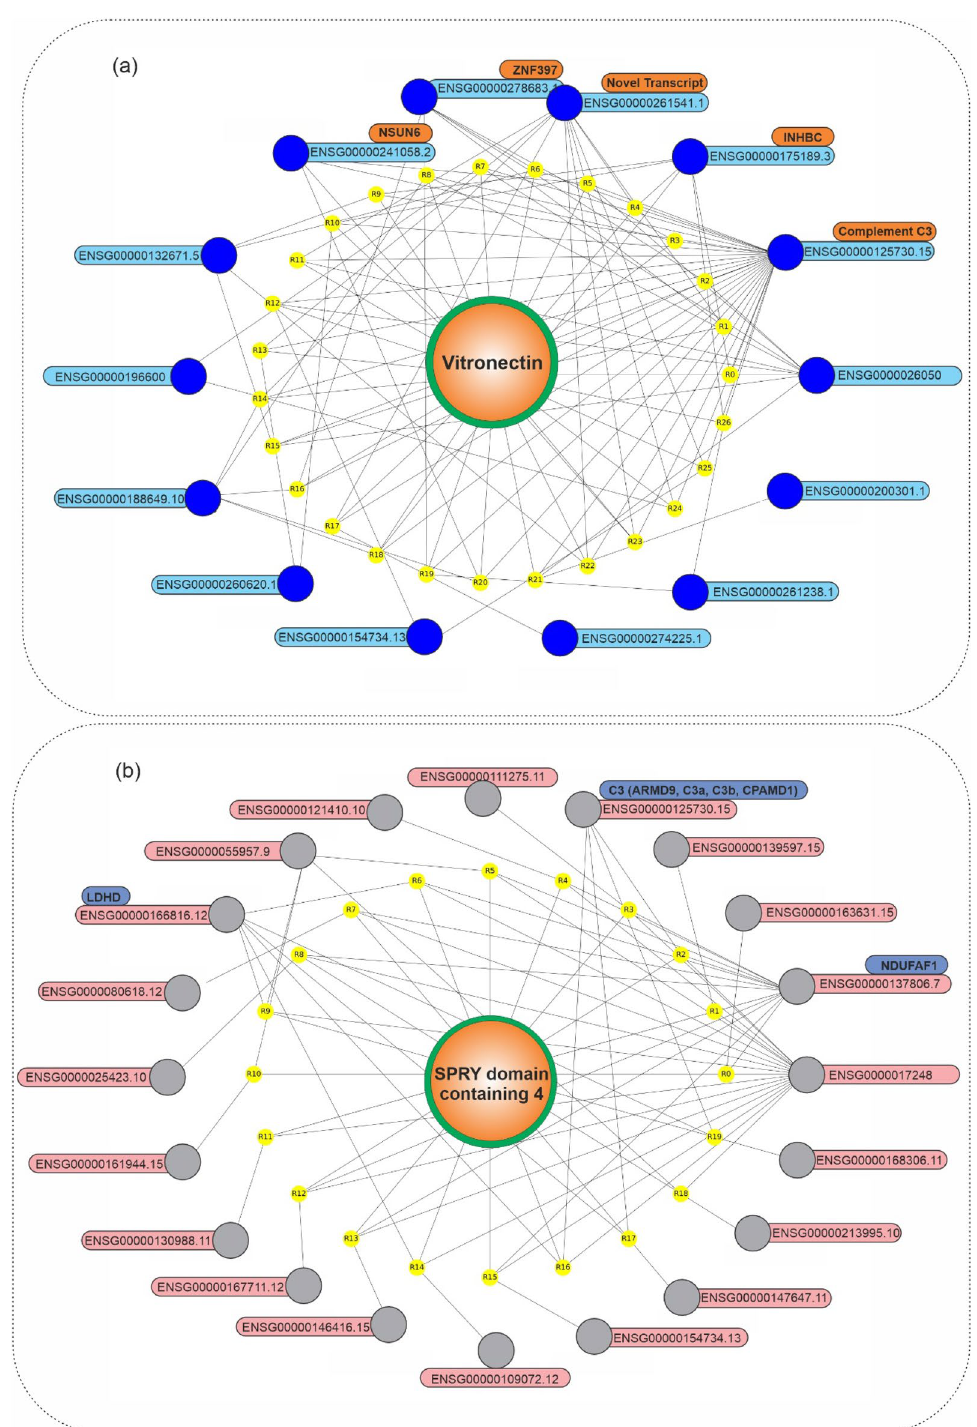
Figure 5. Graph network of Vitronectin and SPRY domain containing 4 in HCC. ( a ) Graph network of Vitronectin (with lift > 1.42) related association rules, in which the Vitronectin, its rules, and related mRNAs were presented, by orange, yellow, and blue colors, respectively. Vitronectin, the most frequent mRNA in the early-stage association rules, has a high dependency on ENSG00000125730 (Complement C3). ( b ) Graph network of the SPRY domain containing 4 (with lift > 1.46) related association rules, in which the SPRY domain containing 4, its rules, and related mRNAs were presented, by orange, yellow, and blue colors, respectively. Python programming language (version 3.9) and Matplotlib library (version 3.6.0) were used to draw the plots, all of them are open